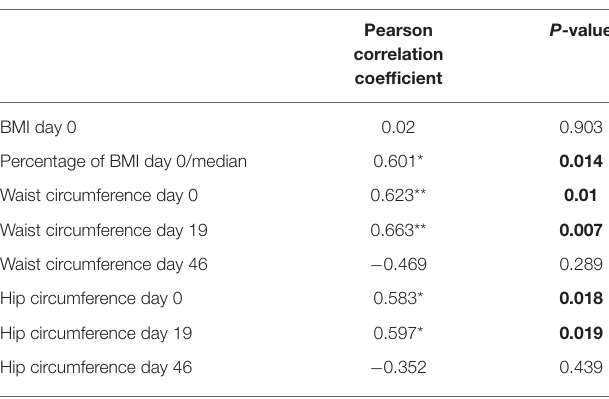
TABLE 6 | Pearson correlation analysis of body mass index, body fat distribution and minimal residual disease day 46.